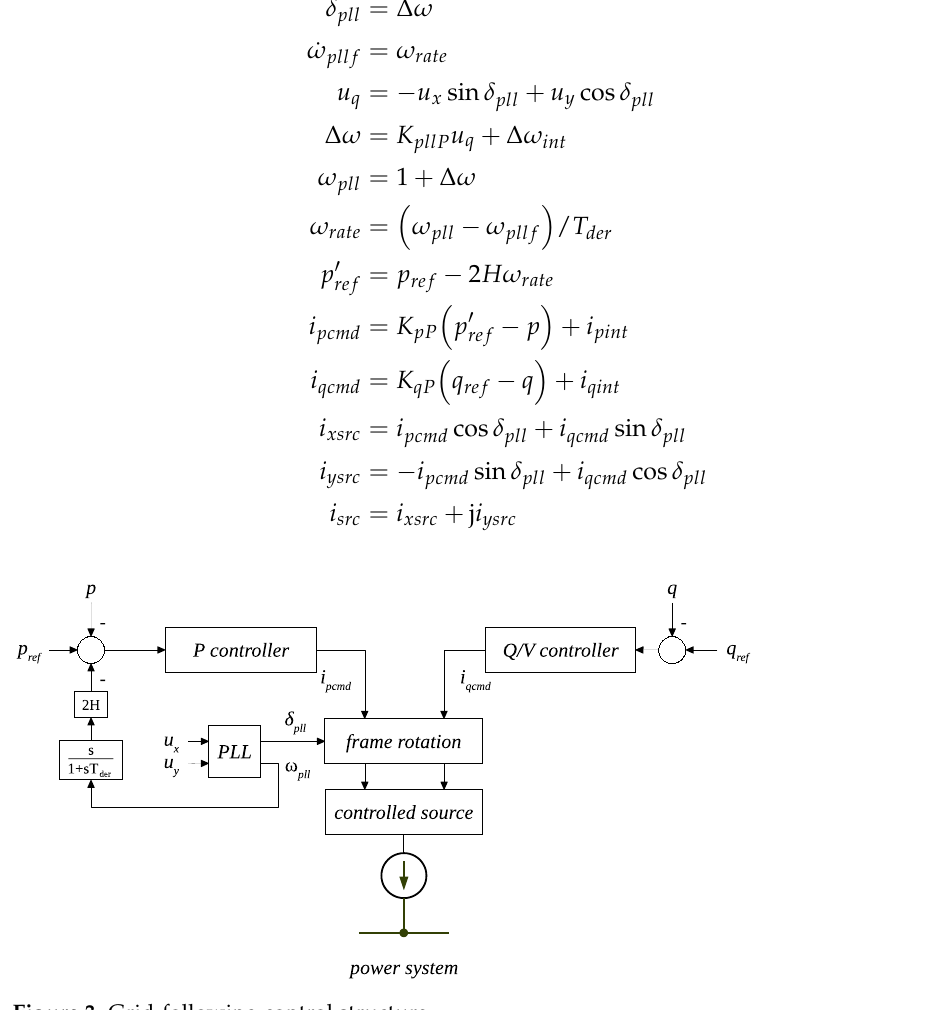
Figure 3. Grid-following control structure.